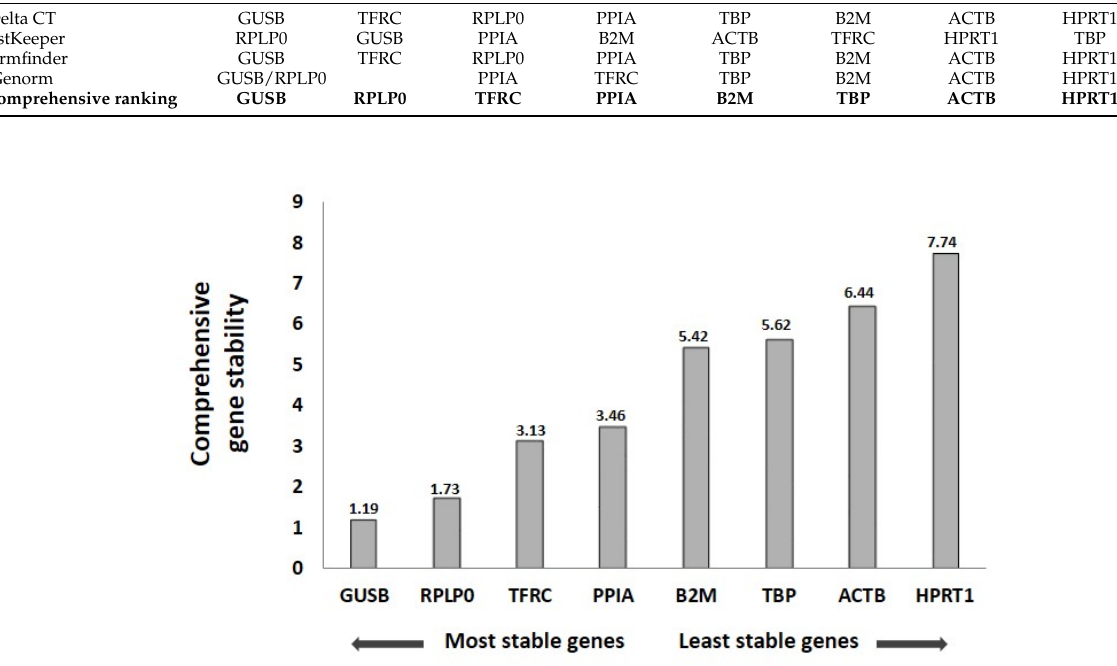
Figure 4. RefFinder ranking of the stability of eight reference genes tested for qRT-PCR analysis in FaDu. FaDu cultures treated with C (control), NP-Ø (unloaded NPs, 0.5 and 0.75 mg/mL), and NP-PHT427 (PHT427-loaded NPs, 0.5 and 0.75 mg/mL) for 24 h.